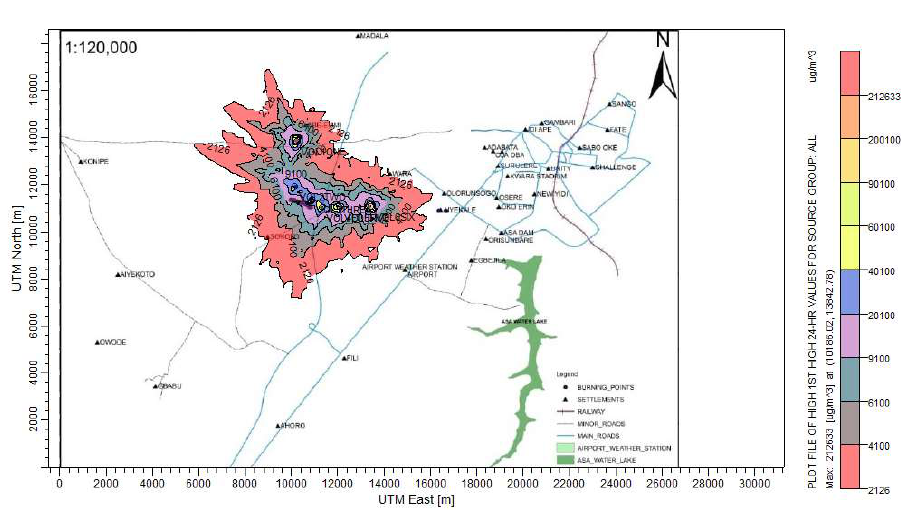
Figure 5. Isopleth of 24-h ground level CO from Sokoto-Aiyekale dump site.